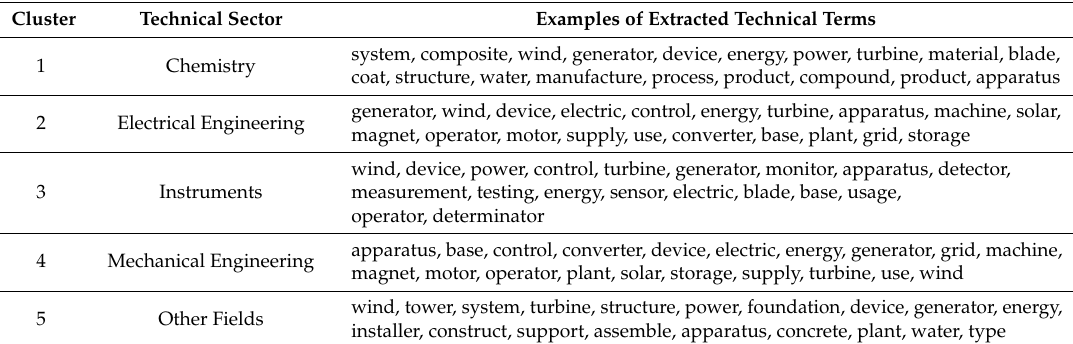
Table 6. Examples of extracted key terms from patent titles.